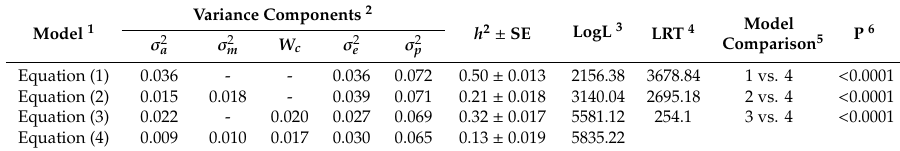
Table 2. Estimates of the variance components, the direct heritability ( h 2 ), the standard error (SE), the log-likelihood values (LogL), and the likelihood ratio test (LRT) values when comparing the four models of the individual birth weight trait in Korean Yorkshire